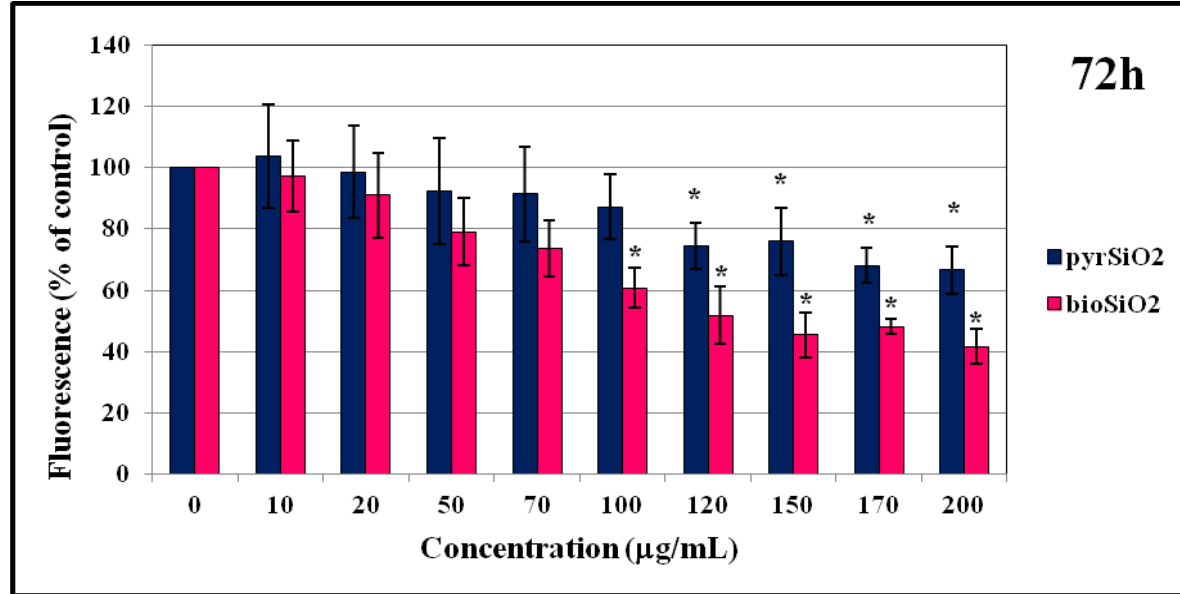
Figure 8. Assay of cell survival based on DNA content. Cell survival of HMEC-1 cell line of silica nanoparticles (pyrogenic and biogenic) was measured by Hoechst 33258 assay after 72 h exposure. Statistical evaluation of differences was made using the ANOVA I and Tukey’s post hoc test, at significance levels of p < 0.01 (*) with respect to control.